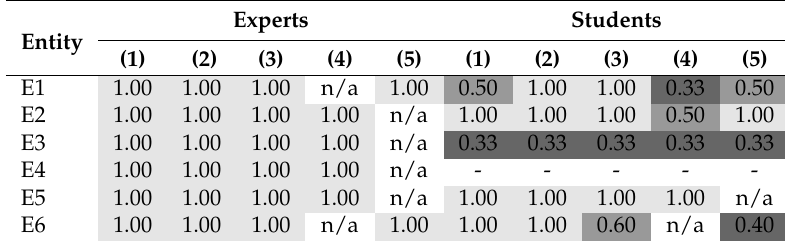
Table 6. Values of Fleiss’s kappa for each program entity displayed for (1) overall quality, (2) size, (3) complexity, (4) cohesion and (5)